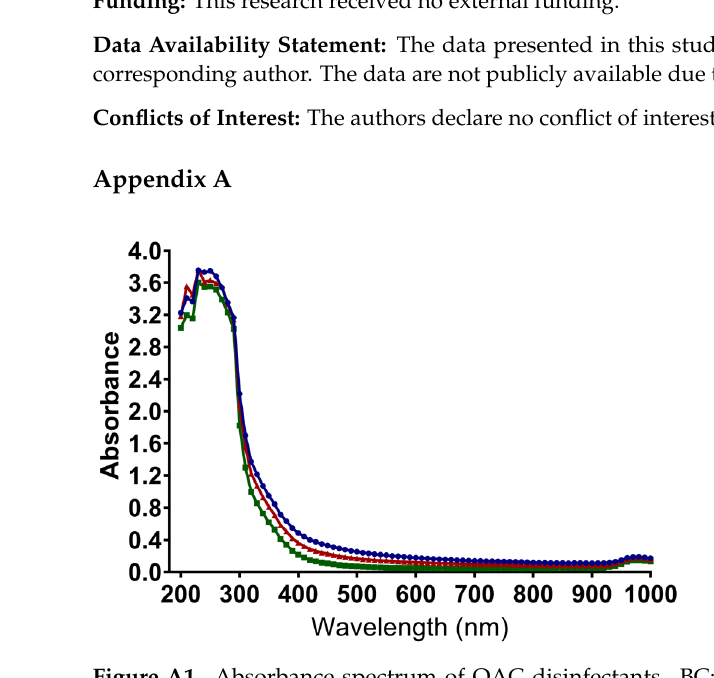
Figure A1. Absorbance spectrum of QAC disinfectants. BC: benzalkonium chloride ( ● ) DDAC: Didecyldimethylammonium chloride ( ▲ ) Virukill™ ( ■ ).